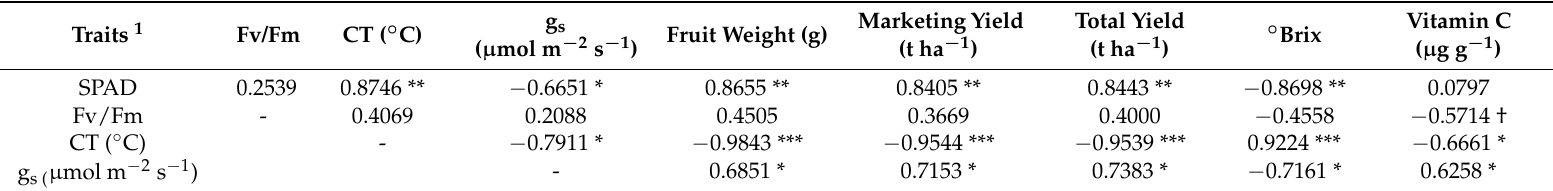
Table 3. Correlation coefficients (r) and significance levels between physiological traits and yield and quality of tomato under non-irrigated (I0) conditions, n = 8.